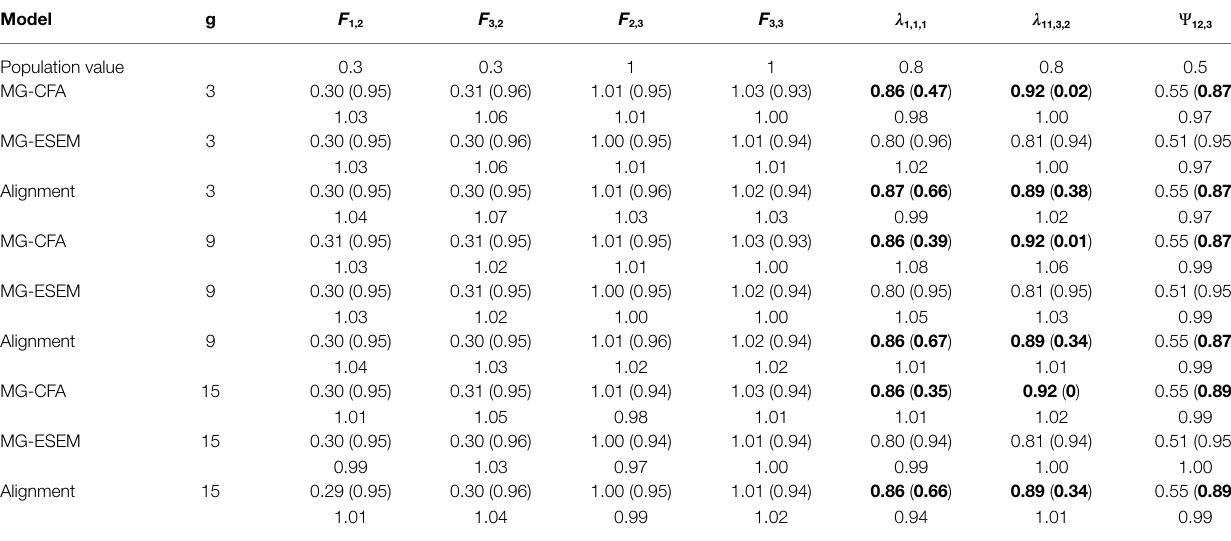
The values inside parentheses are coverage rates, the values on the left side of the parentheses are parameter estimates, the values under the parameter estimates and coverage rates are ratios of average standard error to standard deviation. The values in bold do not meet the four standards which determine the accuracy of parameter estimates proposed in research design section.